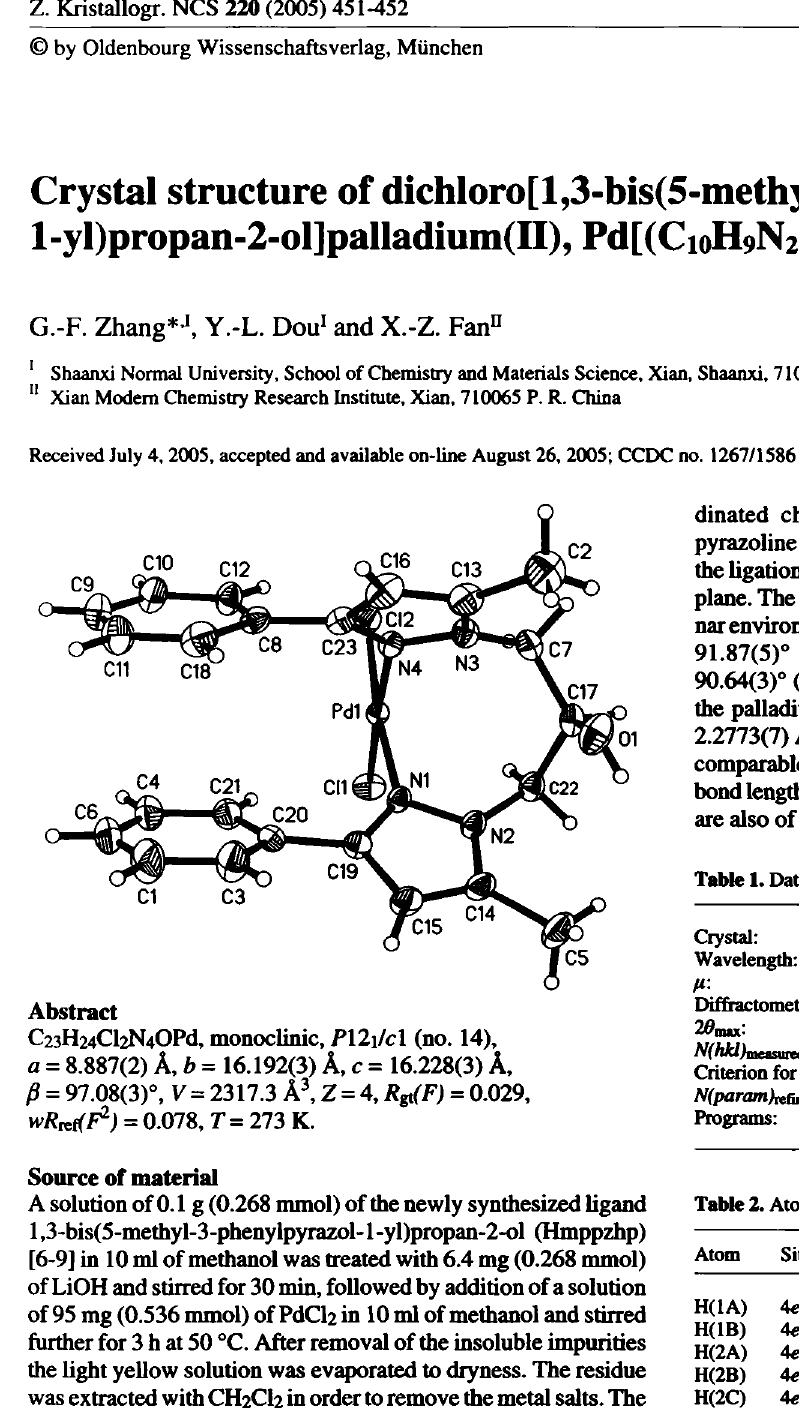
Table 2. Atomic coordinates and displacement parameters (in Ä 2